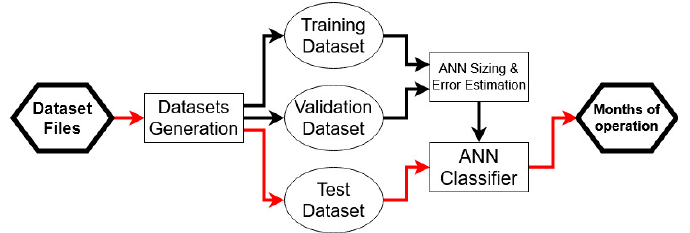
Figure 12. Diagram of the maintenance operation detection stage.